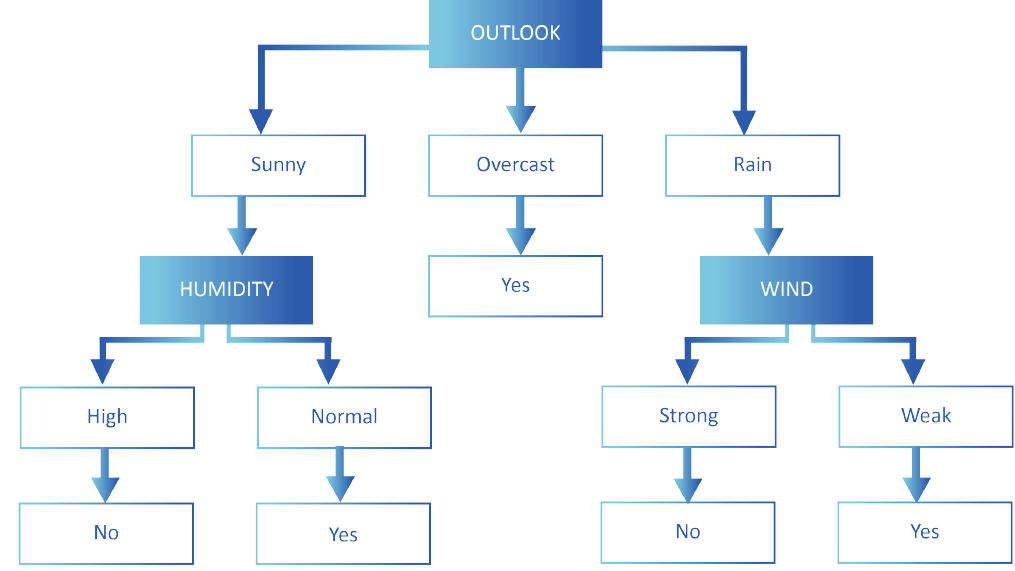
Figure A1. Decision Tree.